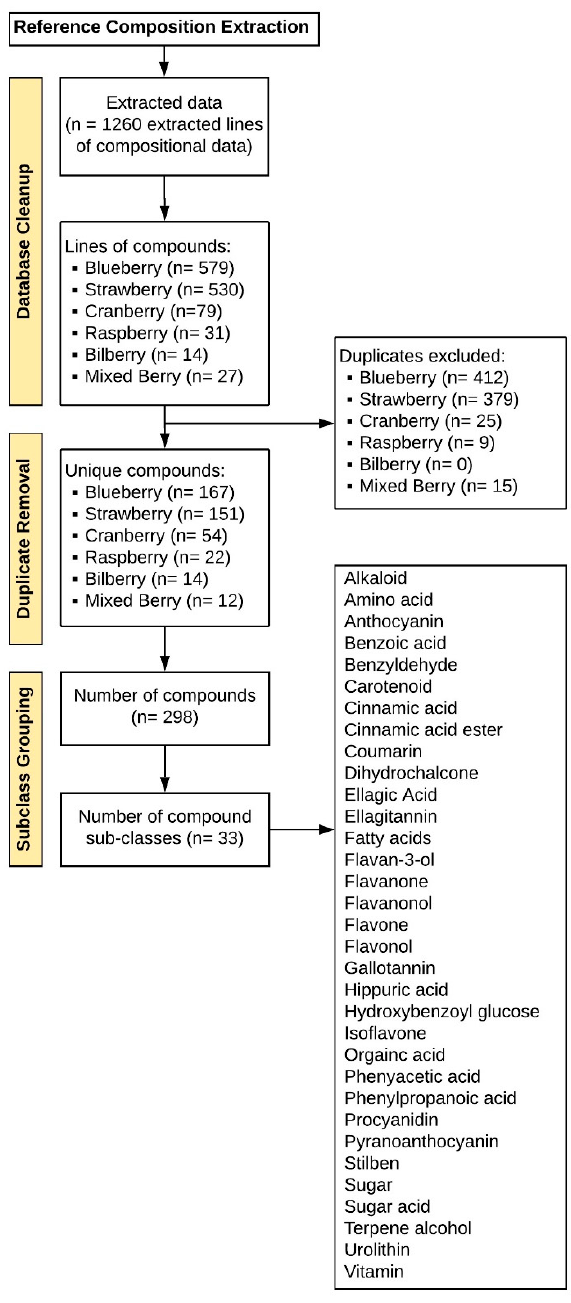
Figure 2. Compositional data extraction.